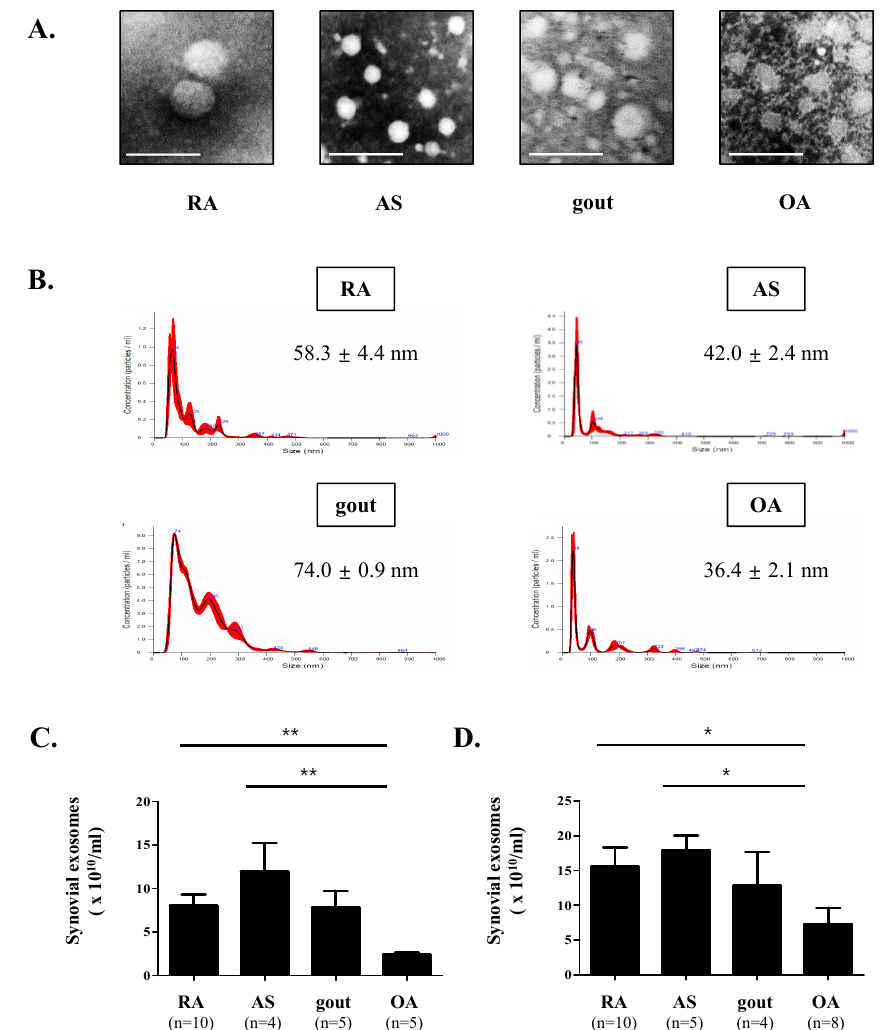
Figure 1. Characterization of synovial exosomes. ( A ) The shape and size of synovial exosomes purified from rheumatoid arthritis (RA), ankylosing spondylitis (AS), gout, and osteoarthritis (OA) patients were observed using a transmission electron microscope (TEM). The size of synovial exosomes ranged in diameter from 20 to 200 nm. Scale bar = 200 nm. ( B ) The size distribution of synovial exosomes was measured using a Nanosight LM 10 and analyzed with enzyme-linked immunosorbent assay (NTA) 3.1 software. Red error bars indicate +/ − 1 standard error of the mean, and the modal size of synovial exosomes are shown for each preparation. ( C , D ) The number of synovial exosomes was assessed by acetyl-CoA acetylcholinesterase (AChE) activity and CD81-ELISA. Data are presented as the mean ± SEM. * p < 0.05 vs. OA, ** p < 0.01 vs.